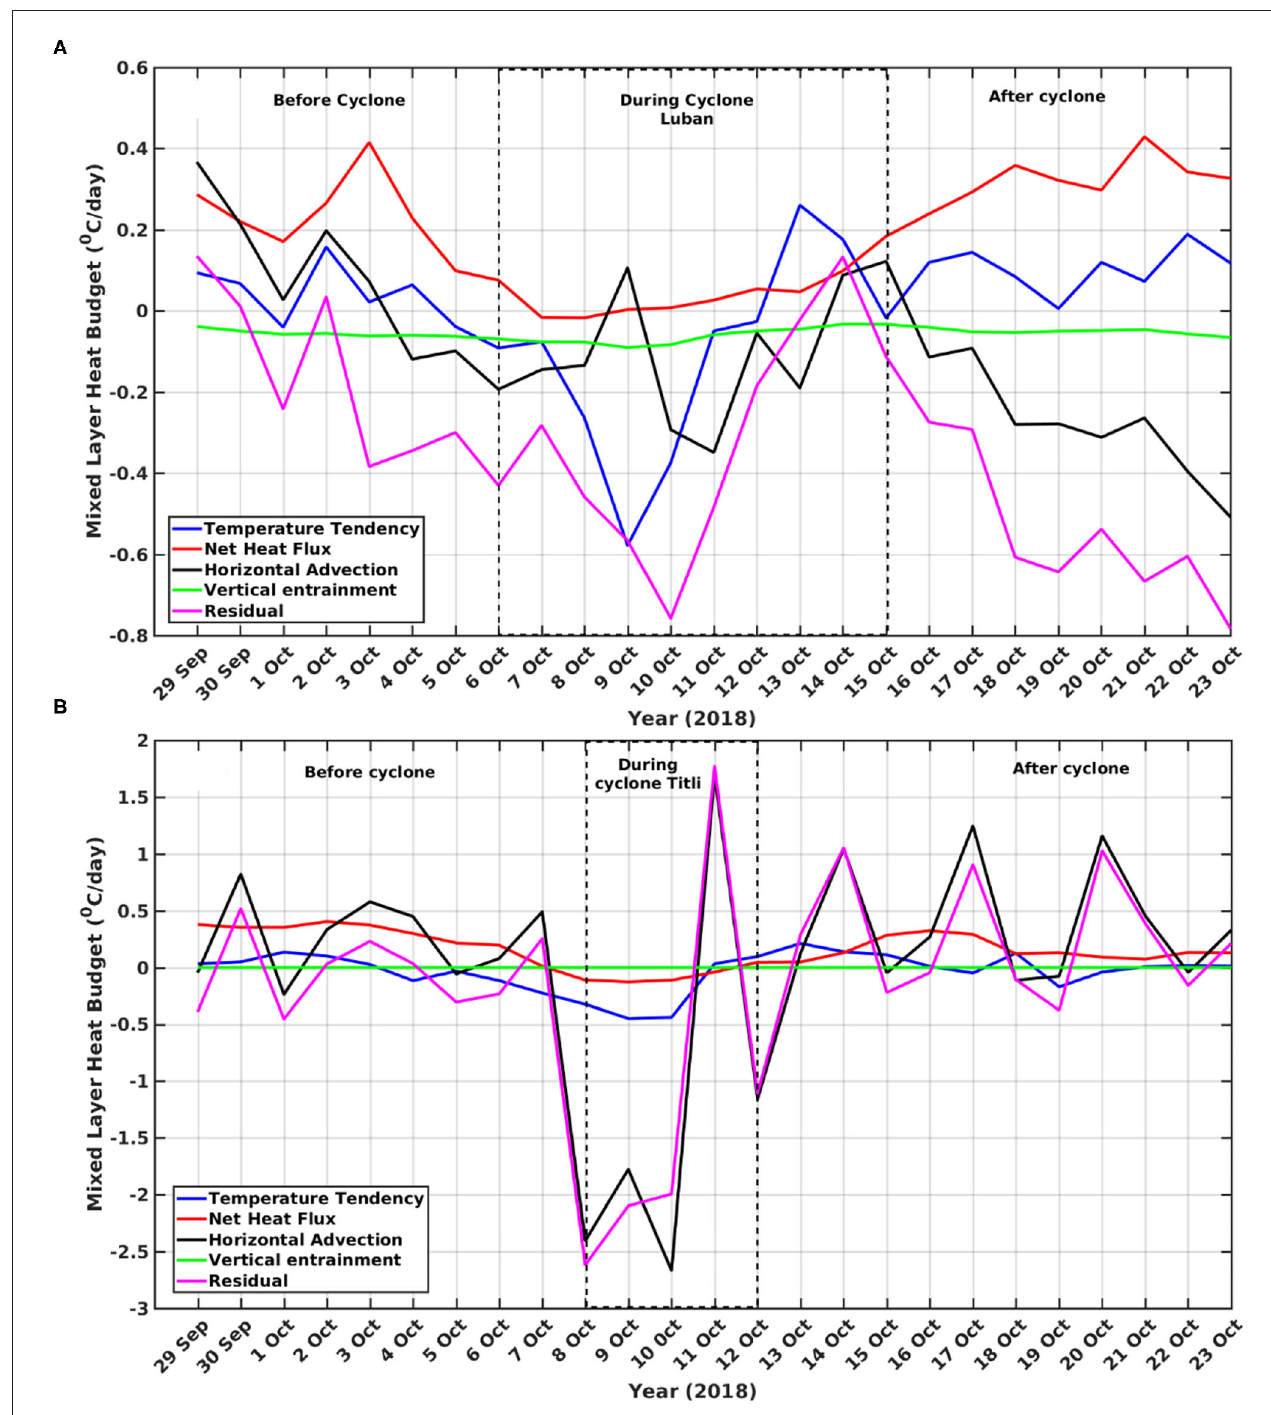
FIGURE 5 | Variation of mixed layer heat budget terms ( ◦ C/day) before, during, and after the passage of the Luban (A) and Titli (B) cyclones. The box with a black broken line over the curve indicates the period of the cyclone.